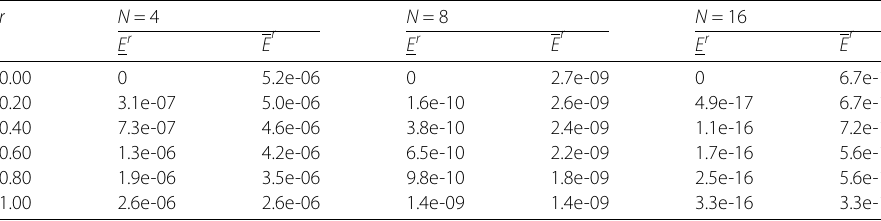
Table 1 Numerical errors on the level sets with N = M in ( x , y ) = (0.5.0.5) for Example